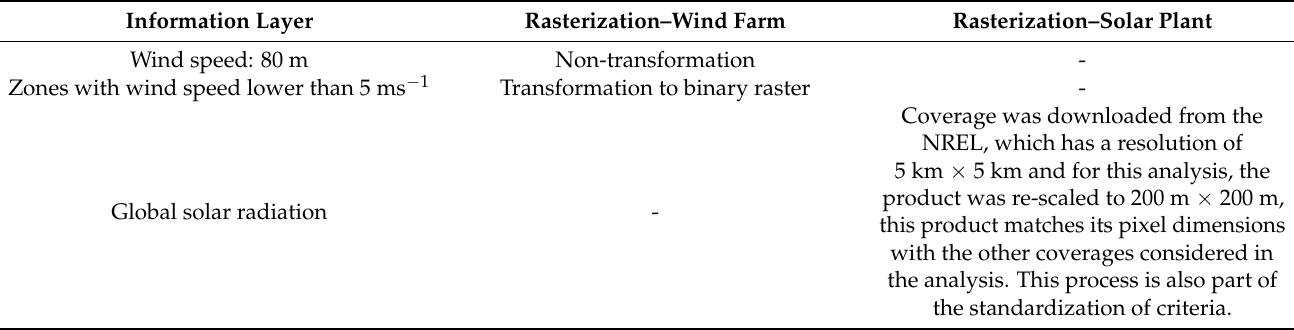
Table 2. Processes applied to wind farm information